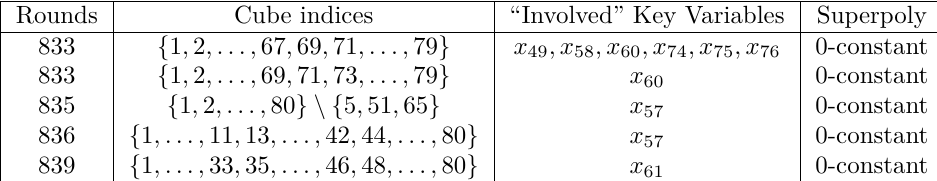
Table 3: The exact superpolies of the cubes given in [WHT +